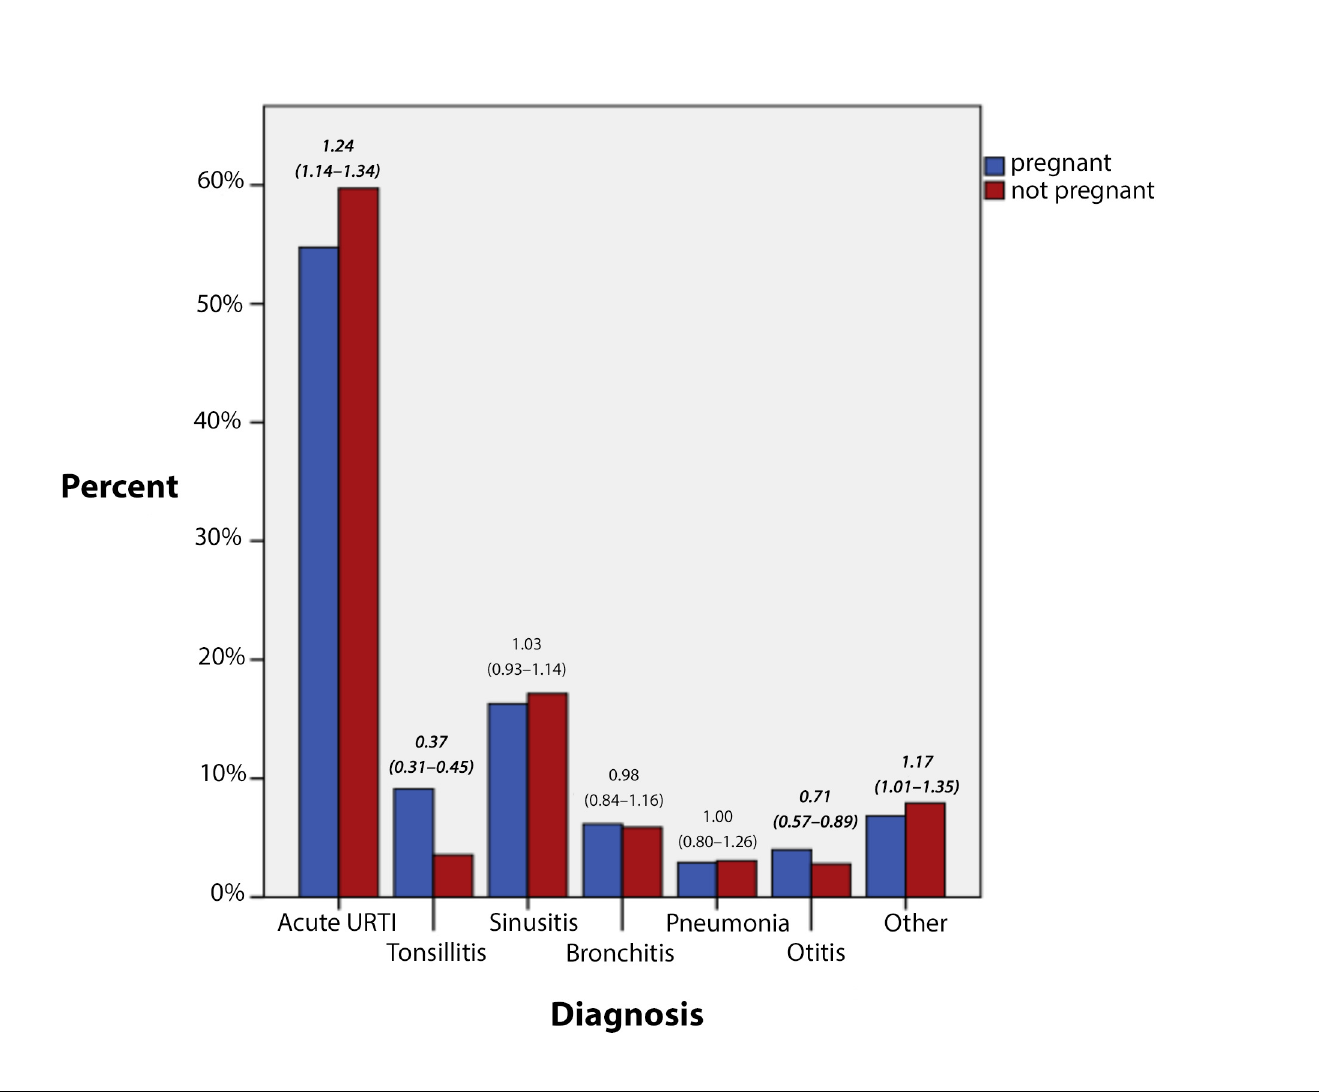
Figure 2. Diagnosis of respiratory tract infection episodes in study period, showing adjusted odds ratio for ’pregnant’ and 95% confidence intervals (significant difference in bold and italic, P <0.05). Diagnoses based on ICPC-2: acute upper respiratory tract infections, URTI (R01–05, 07–29, 74, and 80), tonsillitis (R72 and 76), sinusitis (R75), bronchitis (R78), pneumonia (R81), otitis (H01, 71, 72, and 74), and other respiratory tract infections (R71, 77, 82, and 83). N = 18 890